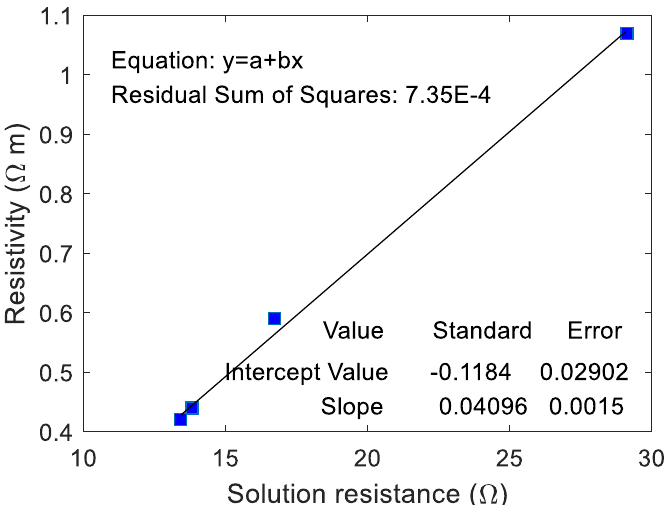
Figure 14. Correlation between resistivity and solution resistance of mortar specimens with different mass ratio of electrolyte solution.